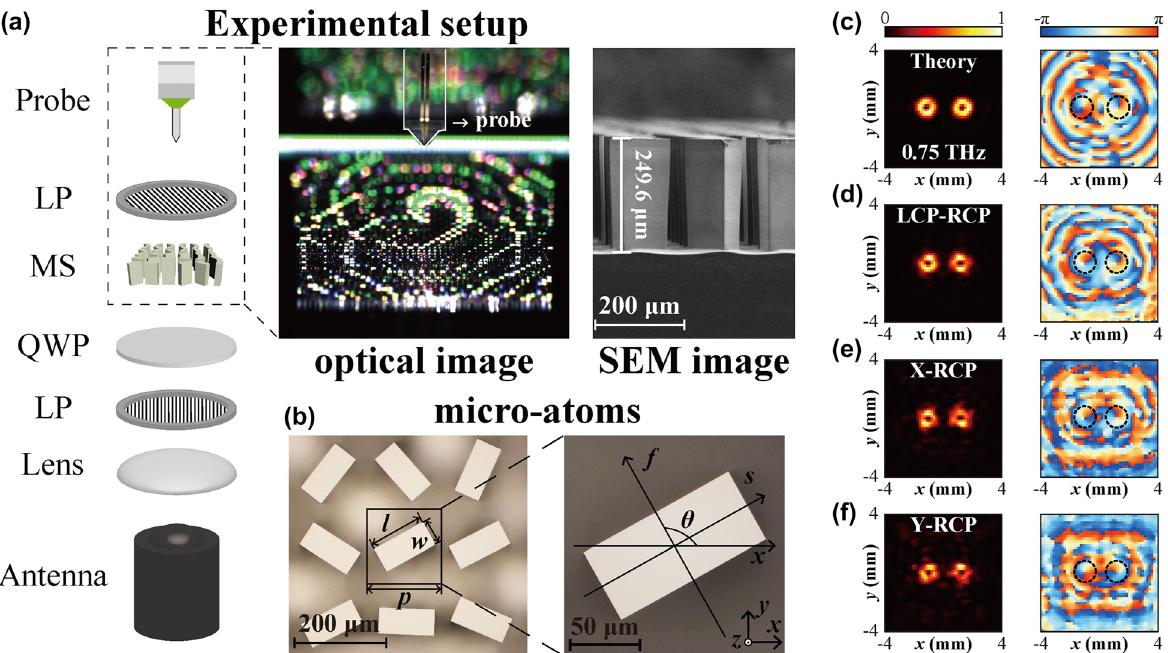
Figure 2: Two-channel vortex beams generation with topological charges of l = 1 and − 1. (a) Left: schematic illustration of the experimental setup. LP, linear polarizer; MS, metasurface; QWP, quarter-wave plate. Middle inset: the optical image of the fabricated Metasurface I sample and terahertz probe. Right inset: SEM image of the fabricated metasurface. (b) Partially enlarged optical image of the fabricated Metasurface I sample. p : period of a unit cell; l/w : length/width of the square column; f / s : fast/slow axis; 𝜃 : rotation angle. (c) The calculated intensity and phase distribution of proposed Metasurface I with the focal length of f = 10 mm. (d) Corresponding measured results with LCP incidence on the measured focal plane ( z = 9 mm). (e) and (f) Measured results of RCP component under horizontally ( X ) and vertically ( Y ) polarized